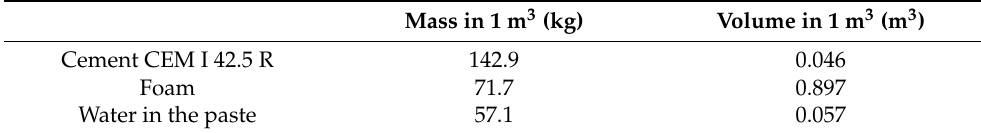
Table 1. Standard mix design of the investigated ultralightweight mineralized foam ( w / c = 0.4).